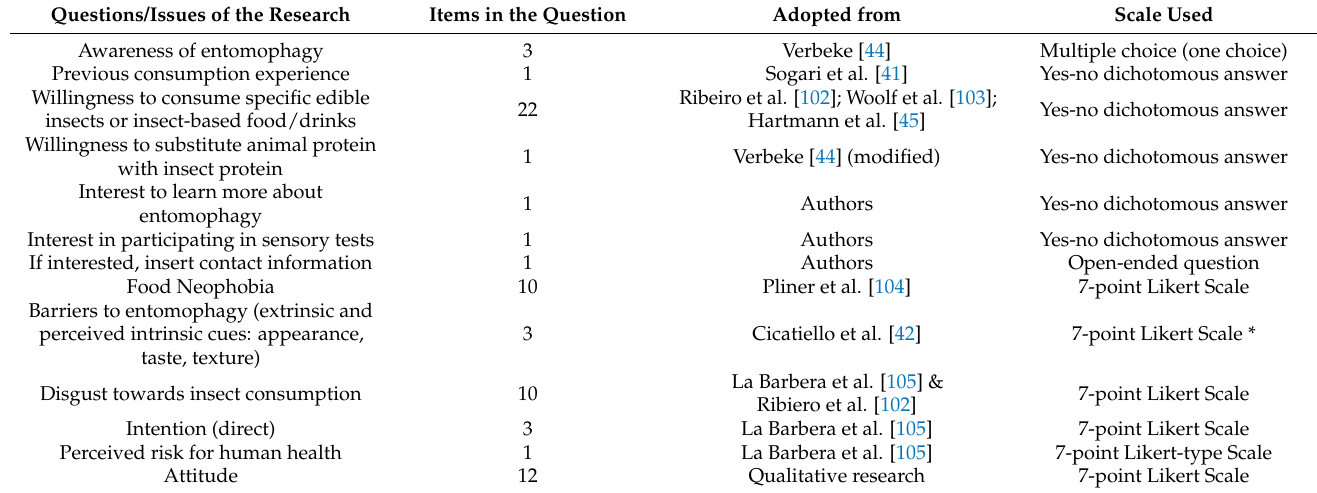
Table 1. Questions used in the study, the authors from whom they were taken, and the scale